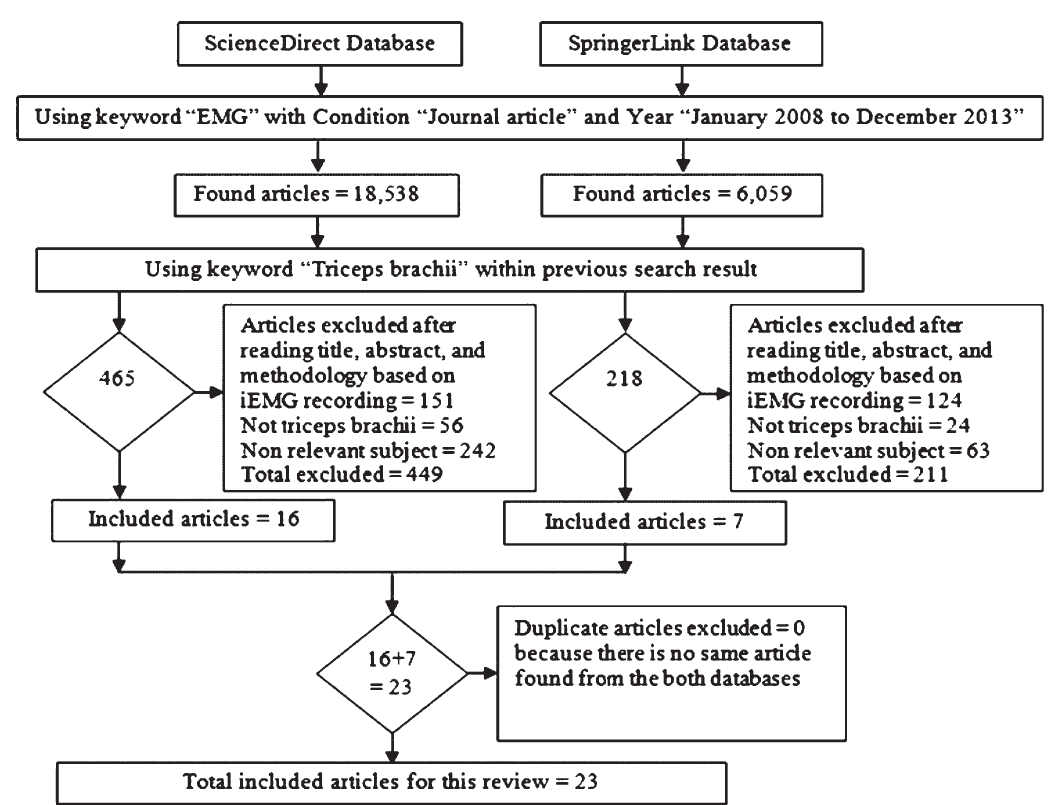
Fig. 2. Articale search